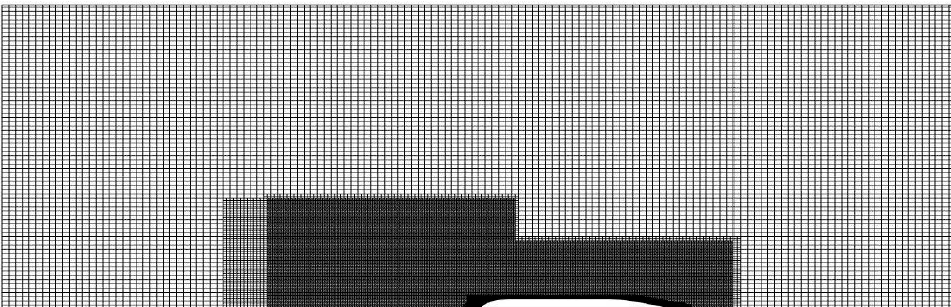
Figure 6. Top view of the computational grid used in the free surface region. The grid is refined to accurately capture the resulting wave system.